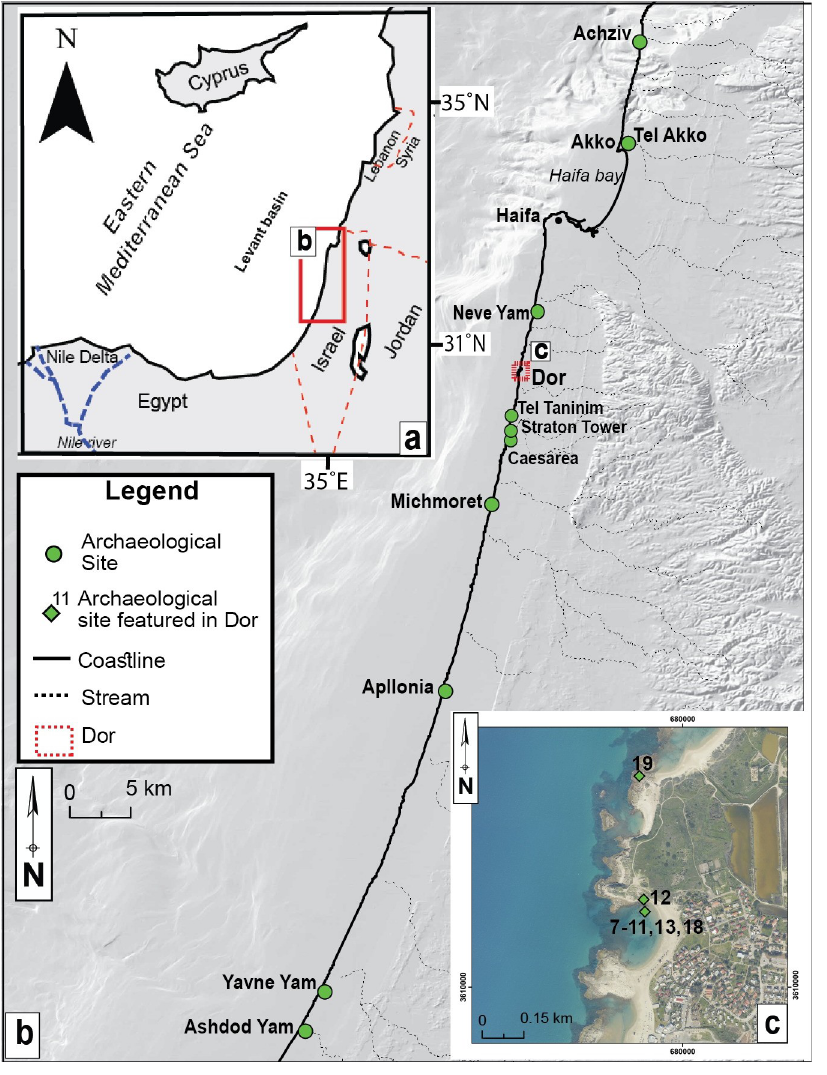
Fig 1. Location maps (a) Israel in the SE Mediterranean modified after natural earth (https://www.naturalearthdata. com in the public domain) (b) Shaded relief of the Israeli coast and location of archaeological sea level indicators and locations discussed in the current study (Republished from [21] under a CC BY license, with permission from [the geological Survey of Israel], original copyright [1994]) (c) Aerial photographs of Dor and the location of the archeological structures used in the current